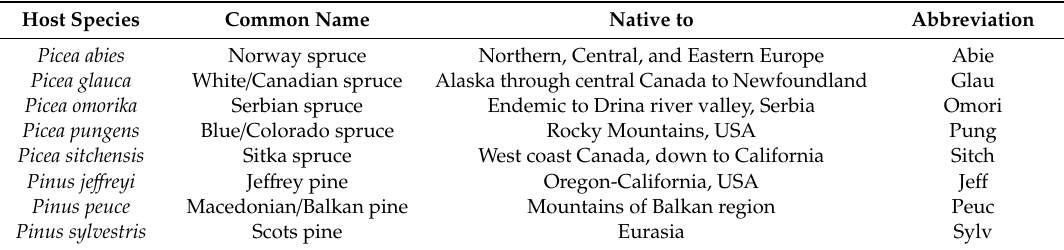
Table 1. List of sampled host conifers, their common names, native ranges, and sample abbreviations used in the